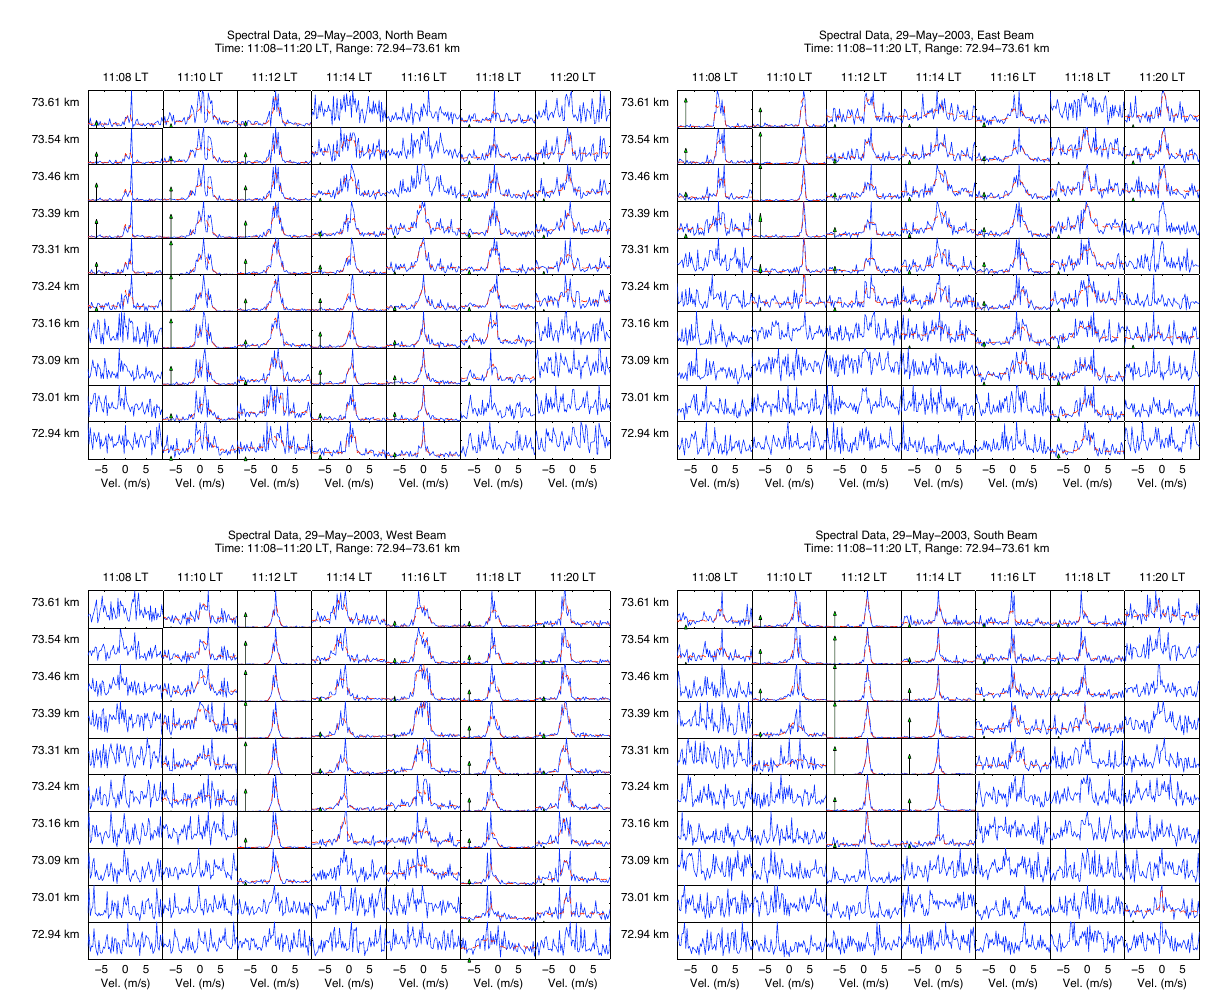
Fig. 21. Spectral data and curve fits from all four beams of event at 73.4km on 29 May 2003 at 11:10 LT.